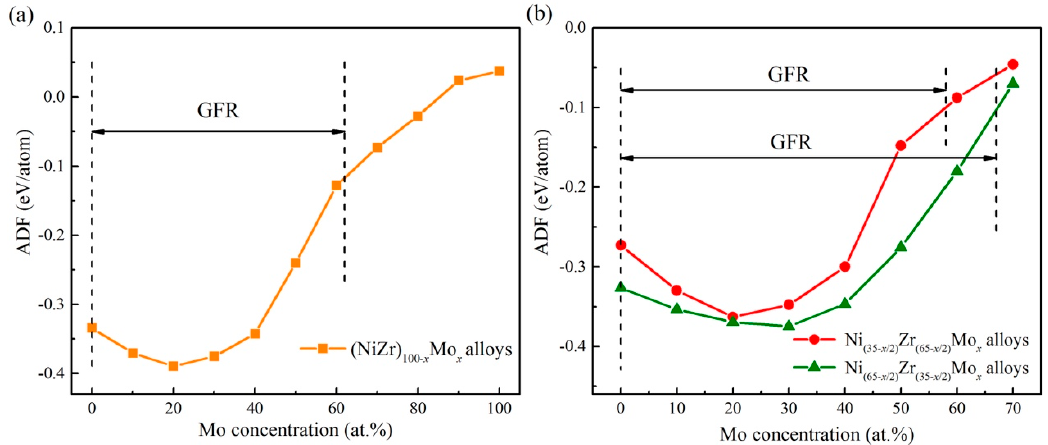
Figure 9. The amorphization driving force (ADF) for the (NiZr) 100 − x Mo x alloy [56] as shown by the XY line in Figure 6 ( a ), as well as the ADF for the Ni (35 − x /2) Zr (65 − x /2) Mo x and Ni (65 − x /2) Zr (35 − x /2) Mo x alloys ( b ). Compared to the (NiZr) 100 − x Mo x alloys, a ADF changing rule similar to that of the Mo addition to the Ni (35 − x /2) Zr (65 − x /2) Mo x and Ni (65 − x /2) Zr (35 − x /2) Mo x alloys can be observed in Figure 9b.Therefore, it is